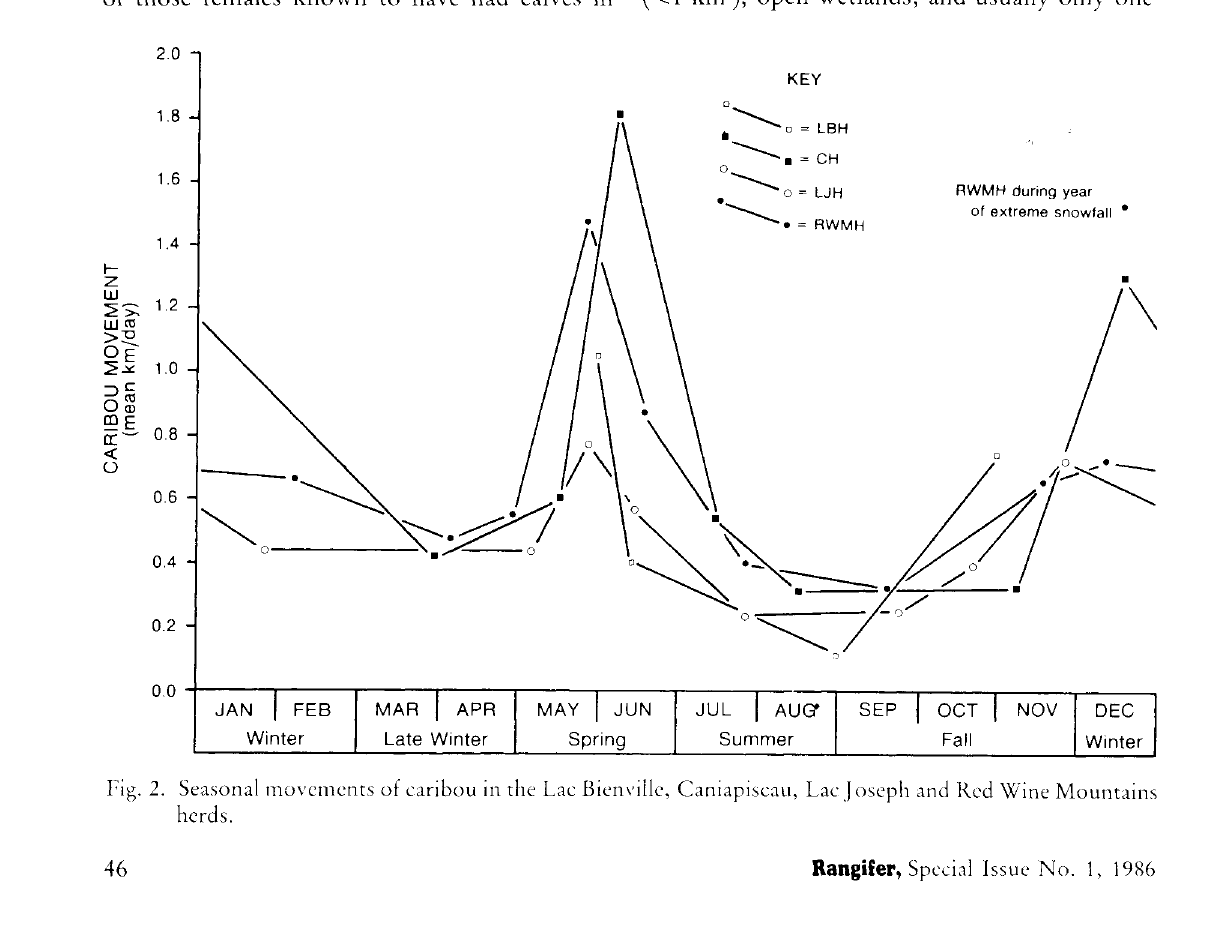
Fig. 2. Seasonal movements of caribou in the Lac Bienville, Caniapiscau, Lac Joseph and Red Wine Mountains